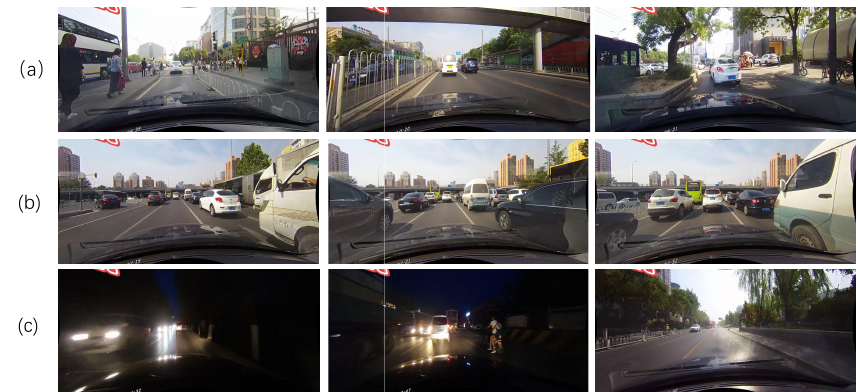
Figure 1. Examples of complex traffic driving scenarios. ( a ) Lane lines with different appearances. ( b ) Dynamic driving scenes. ( c ) Complex surrounding